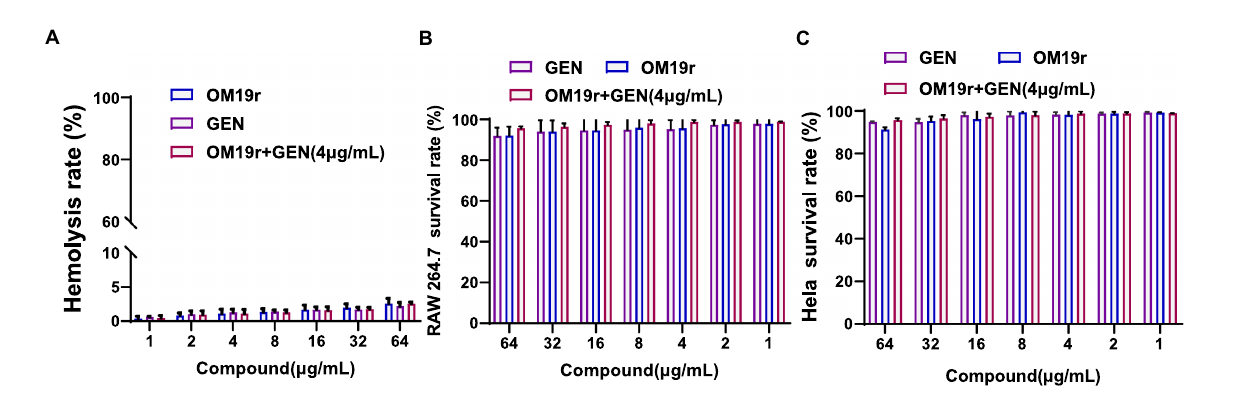
FIGURE 3 Safety evaluation of OM19r combined with GEN at cell level. (A) , Hemolysis of sheep red blood cells treated with OM19r combined with GEN. (B) Cytotoxicity of RAW264.7 cells treated with OM19r, GEN and OM19r combined with GEN. (C) Cytotoxicity of HeLa cells treated with OM19r, GEN and OM19r combined with GEN. Graphs show mean of three biological replicates, p -values were determined using an unpaired two-tailed Student’s t-test.